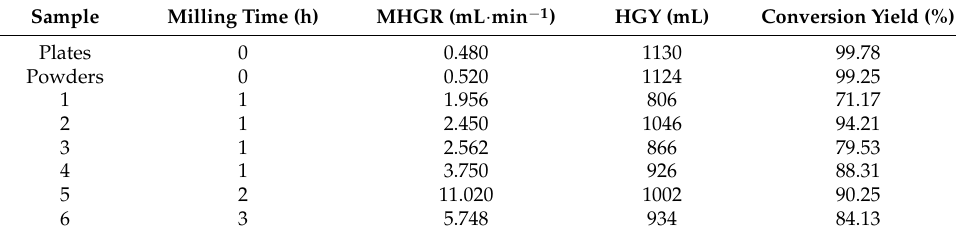
Figure 6. The hydrolysis reaction between Al-LMP-NiCl 2 powders with tap water under different ball milling times: ( a ) hydrogen generation flow rate, ( b ) hydrogen generation yields. Table 3. Hydrogen generation properties of the samples with different ball milling parameters.